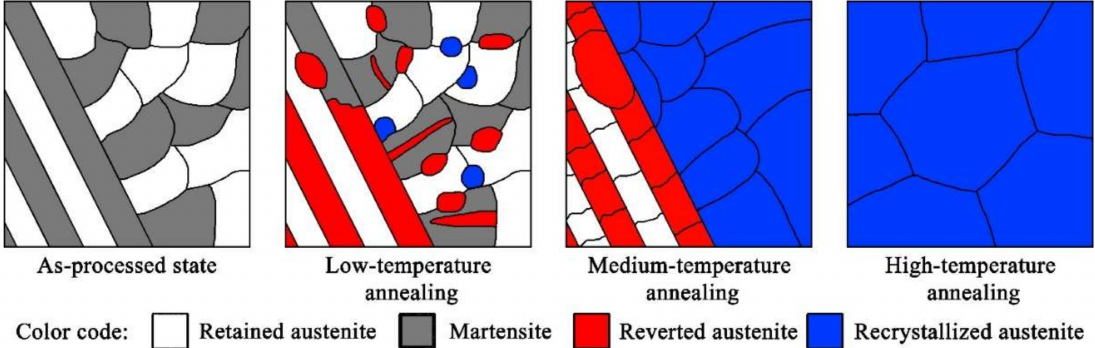
Figure 9. Scheme of the structure evolution during phase reversion